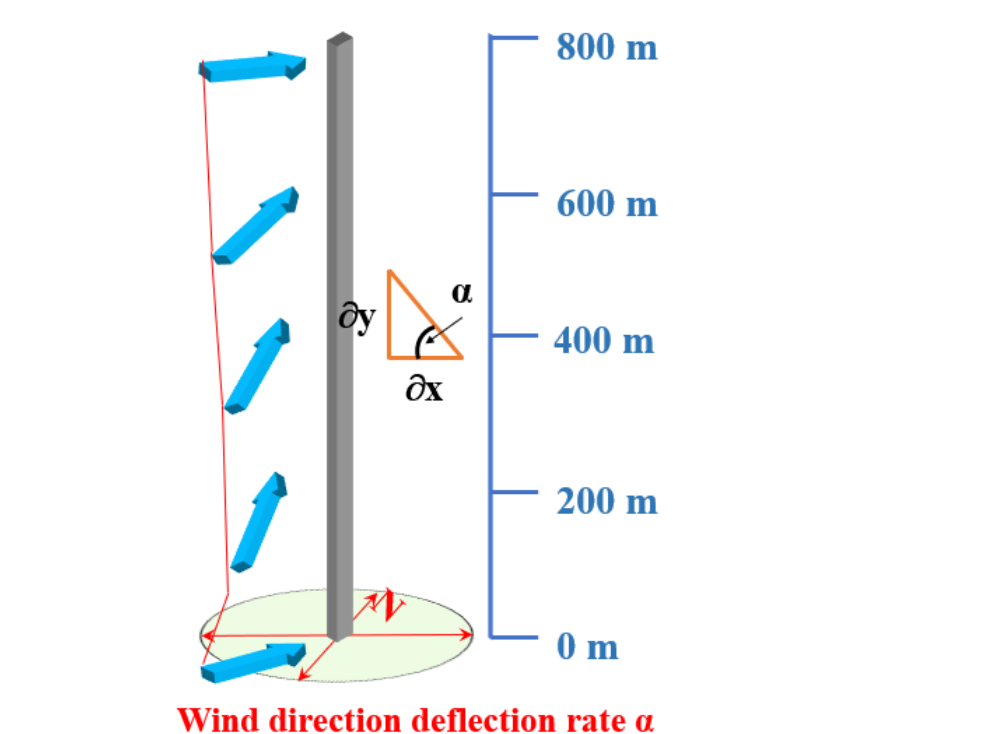
Figure 18. The law of wind direction changes with height. 10